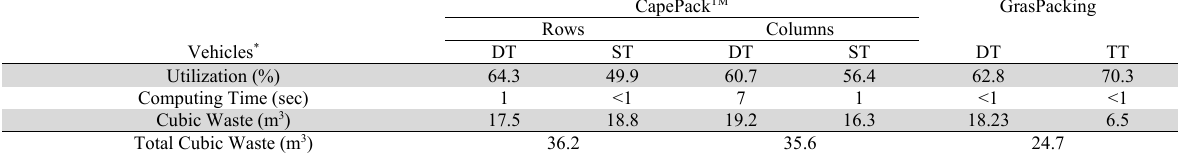
CapePack TM GrasPacking